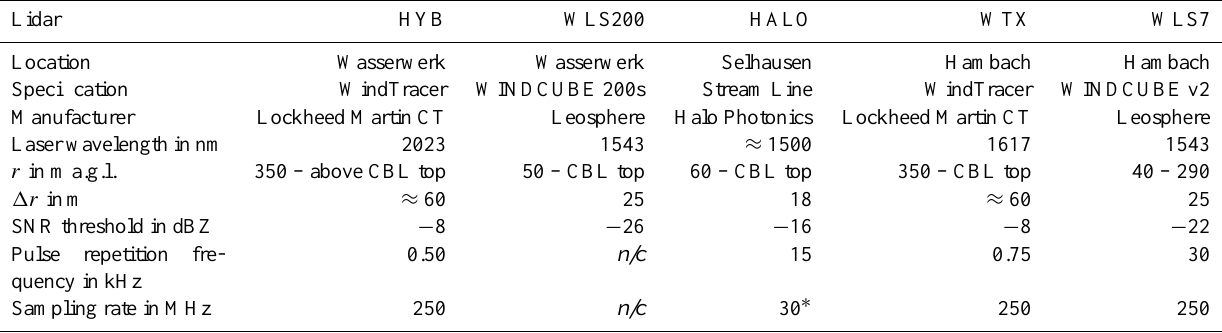
Table 1. Overview of lidar instruments at the three sites, with abbreviations used in the text, measurement range r for the vertical stare mode, range-gate length (cid:49)r , and applied threshold of signal-to-noise ratio (SNR; w measurements with SNR below the threshold were not used in this study); n/c for “not communicated”, ∗ according to Pearson et al.